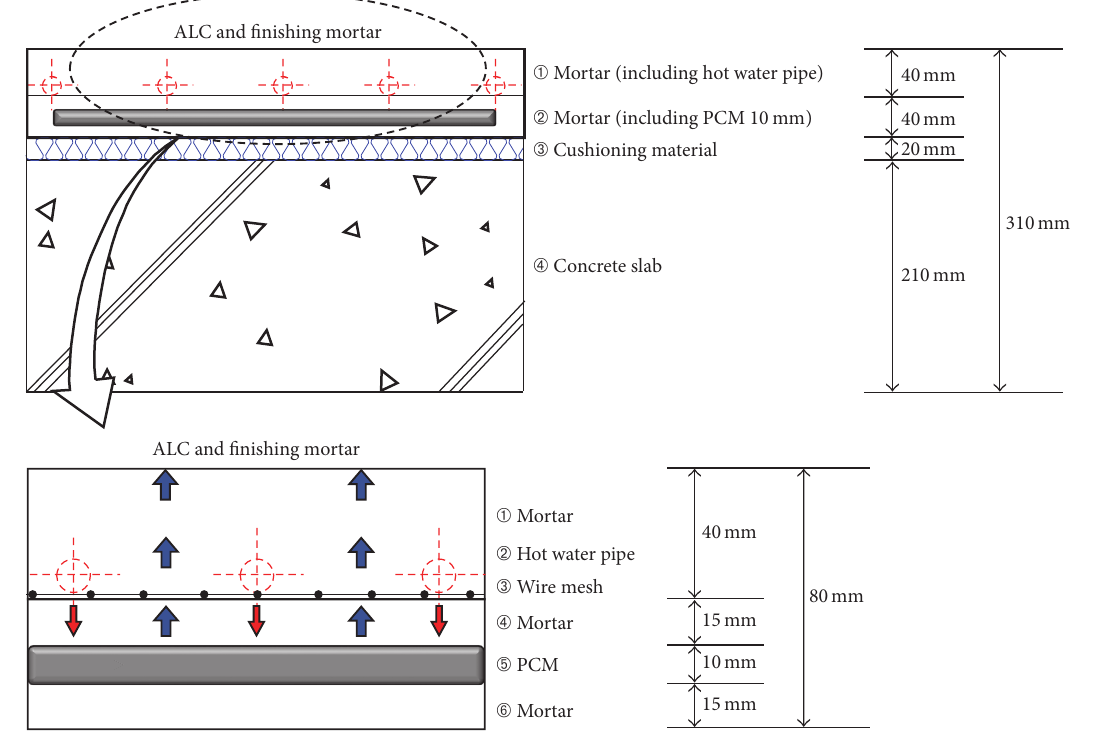
Figure 2: Design and characteristics of PCM underfloor heating system.